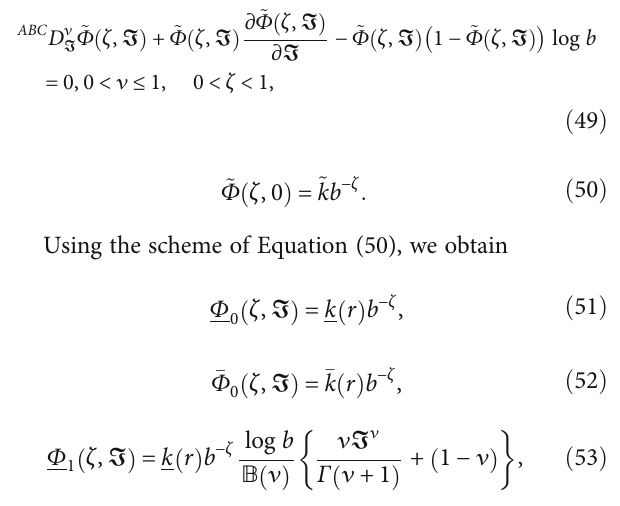
Figure 1 indicates how the e ffi ciency of various (upper and lower bound accuracy) surface plots for example 1 connect with the fuzzy Atangana-Baleanu operator and Shehu transforma- tion are being showed in this research. Figure 2 shows that the lower and upper bounded graph of two dimensional. The ~ Φ ð ζ , I Þ on pattern identi fi es the fl uctuation in the mapping the space coordinate ξ with the considering of I and the uncer- tainty parameter r ε ½ 0, 1 (cid:2) . The fi gure shows that, as time passes, ~ Φ ð ζ , I Þ will become more intricate. the mapping Example 2. The second example is of a fuzzy fractional gas dynamics equation along with a fuzzy initial condition, as follows